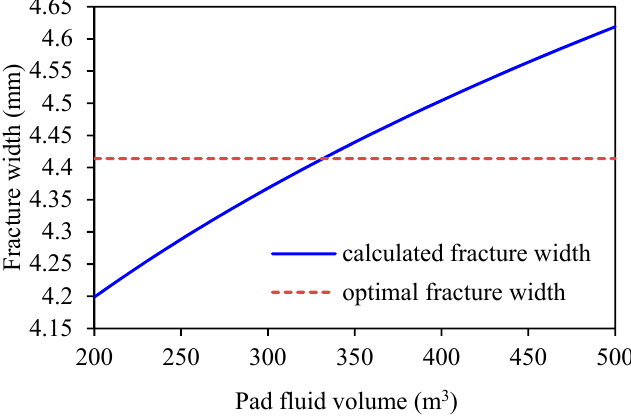
Figure 9. Curves of propped fracture width vs. pad fluid volume for the second adjusted design. Table 2. Ranges of parameters used in optimization. Table 3. Optimization